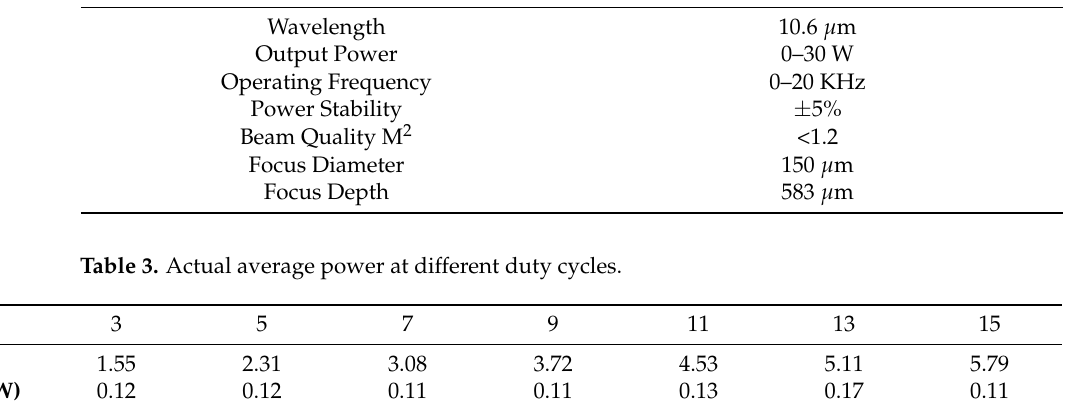
Table 3. Actual average power at different duty cycles.